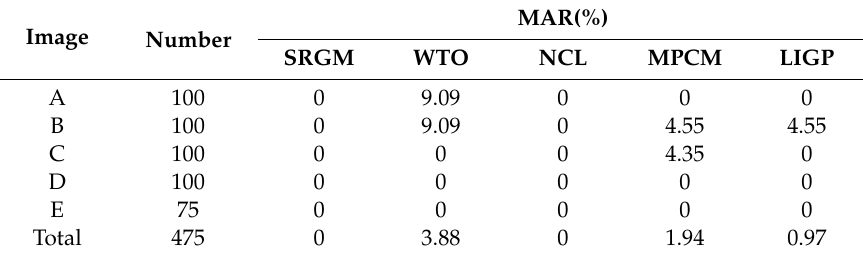
Table 2. MAR of five detection algorithms.